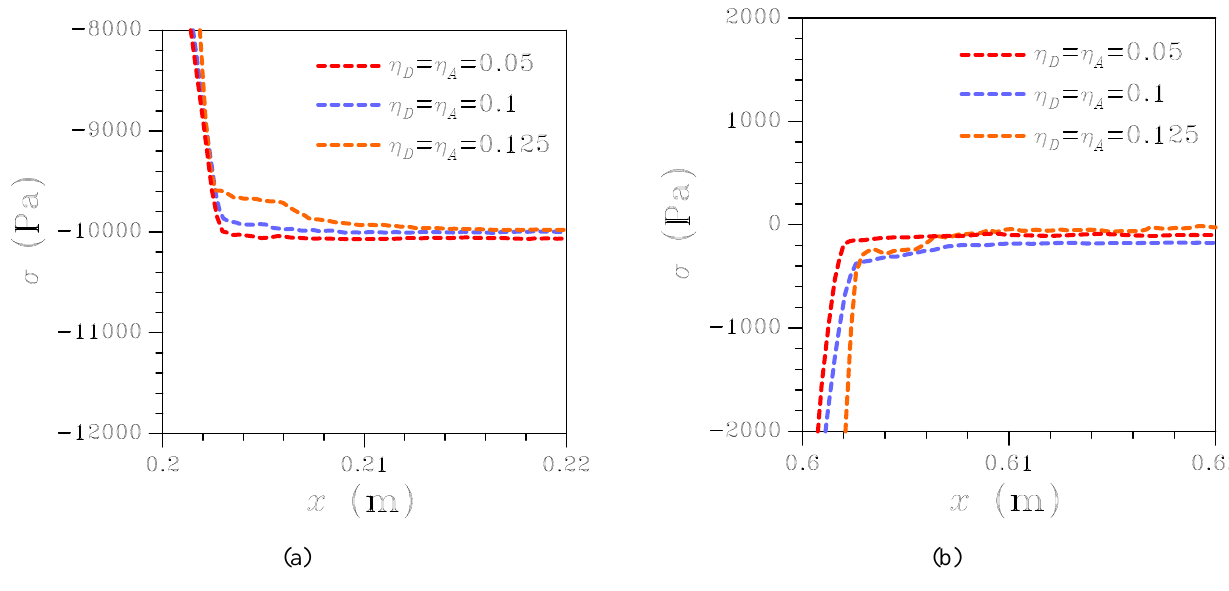
Figure 7. Wave propagating along a homogeneous rod discretized with an unstructured mesh: stress field at t = 1 . 8 · 10 − 2 s. Effect of parameters η newly proposed FE-FCT scheme to accurately track the stress discontinuity across the wave